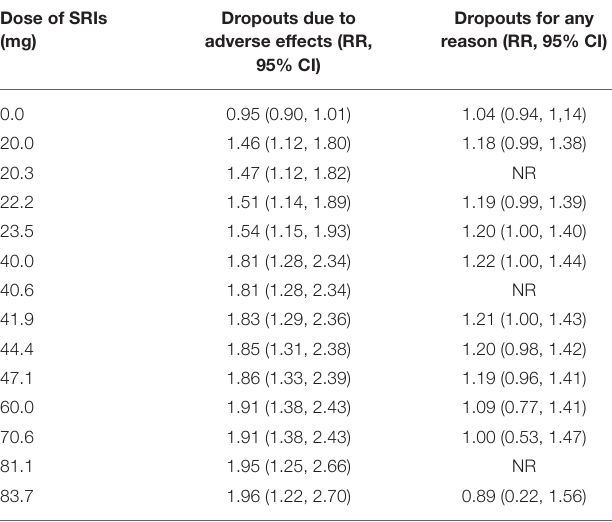
TABLE 3 | RRs for tolerability and acceptability at various doses of SRIs. Dose of SRIs (mg)